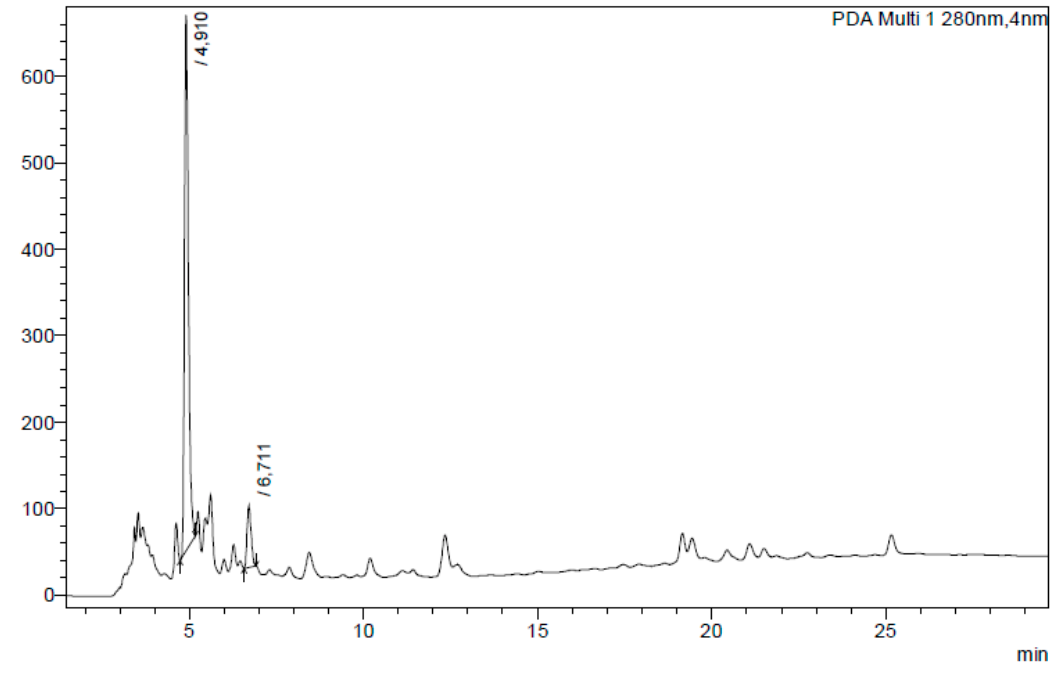
Figure 3. HPLC chromatogram at 280 nm of the EOP extract obtained with water at optimal conditions (85 °C, 10% solids, and 90 min). Peak numbers 1 and 2 correspond to hydroxytyrosol and tyrosol, respectively.